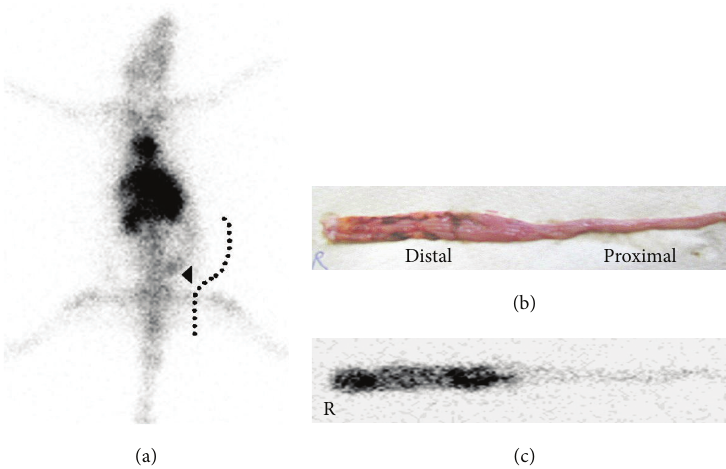
Figure 6: Four-hour 99 m Tc-infliximab distribution in a rat with TNBS-colitis: (a) whole body image (annotated line represents the descending colon, with increased uptake 󳶣 in distal colon); (b) resected intestine after TNBS exposure (distal inflammation); and (c) radiotracer distribution in the same resected specimen (R =